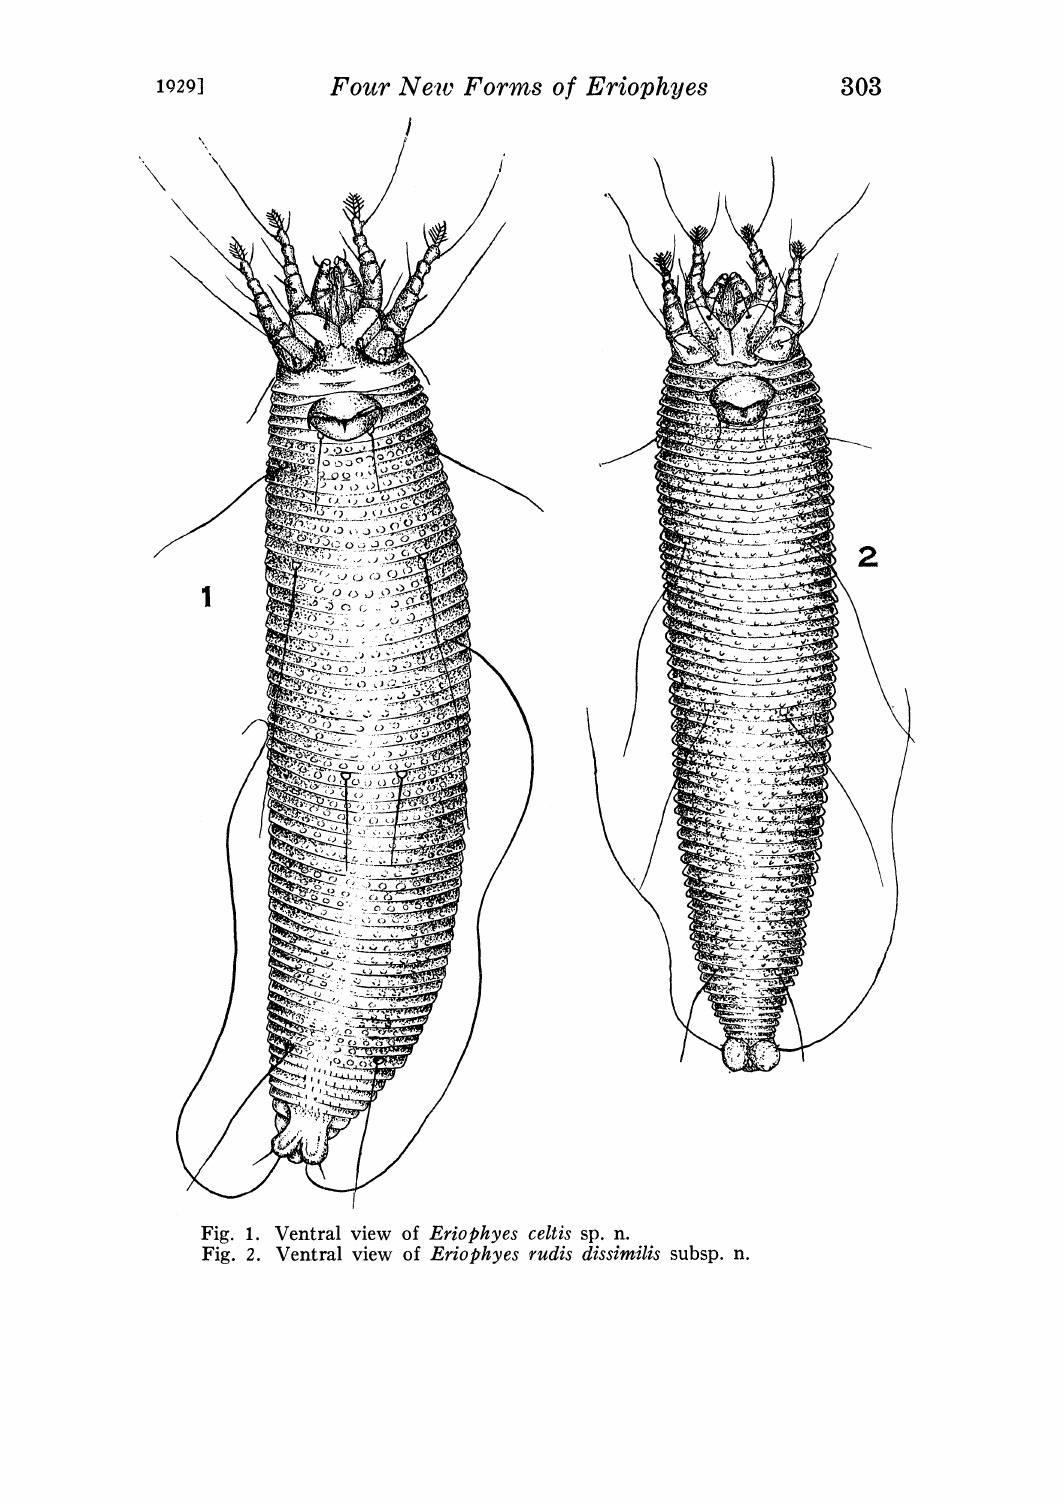
Fig. 1. Ventral view of Eriophyes celtis sp. n. Fig. 2. Ventral view of Rriophyes rudis dissimilis subsp,